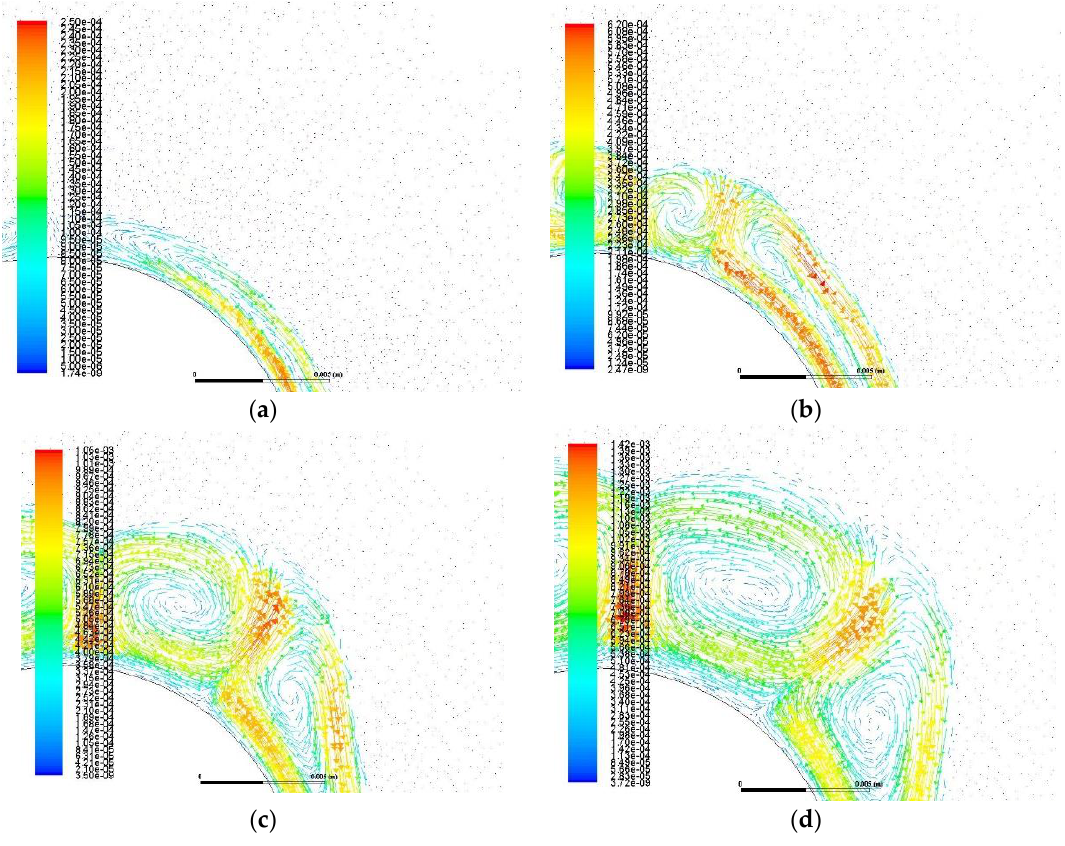
Figure 12. Velocity field at 100 s ( a ), 300 s ( b ), 500 s ( c ) and 700 s ( d ).